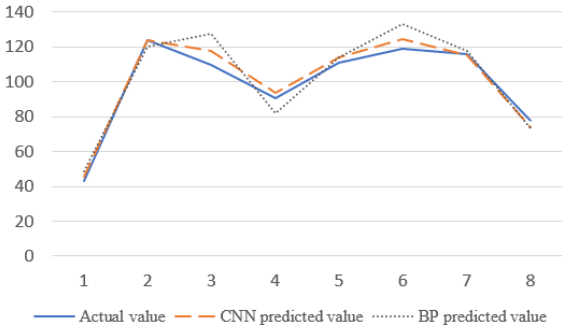
Figure 11. Comparison of prediction results.